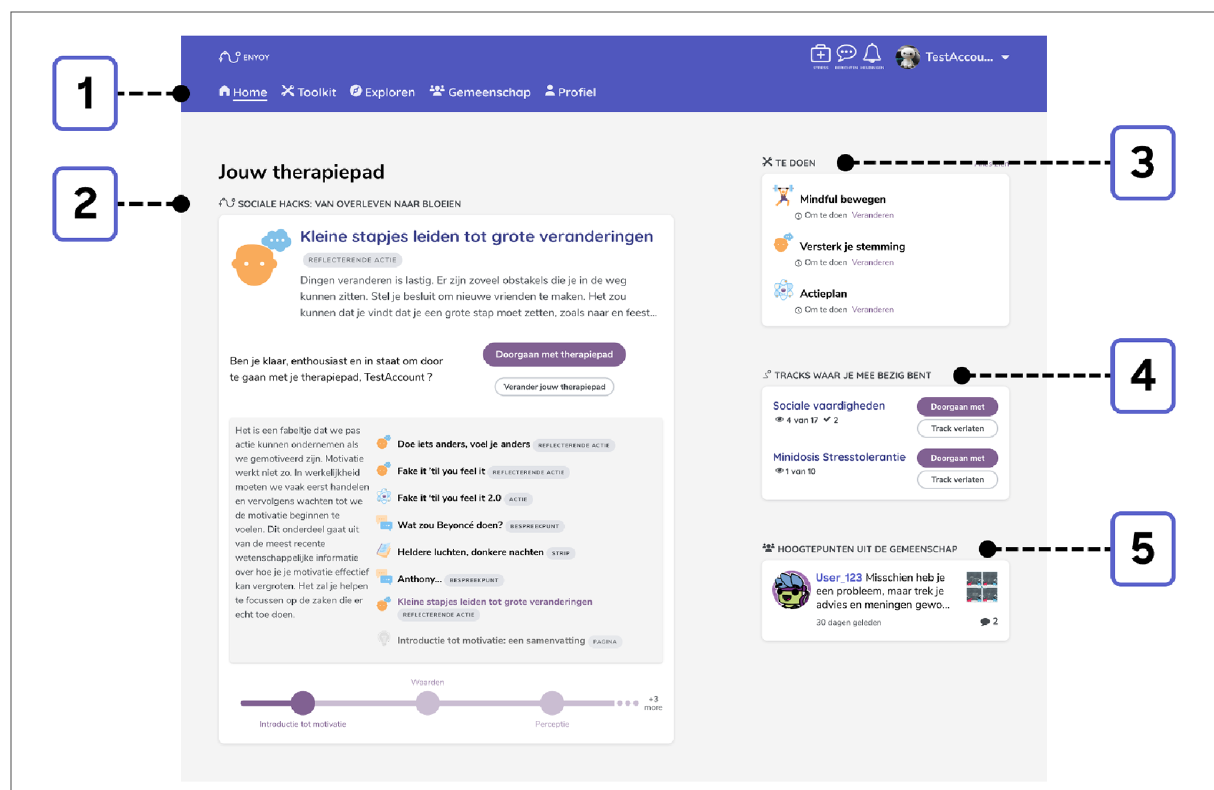
FIGURE 2 Exemplary homepage. 1=Navigation through ENYOY (Home / Toolkit / Explore function / Community / Pro fi le); 2=Personalized therapy journey with a summary of next exercise;| 3=To do list consisting of previously saved exercises (e.g. mindfulness); 4=Overview of started stand-alone tracks regarding certain subjects (e.g. social skills); 5=Highlighted messages in the